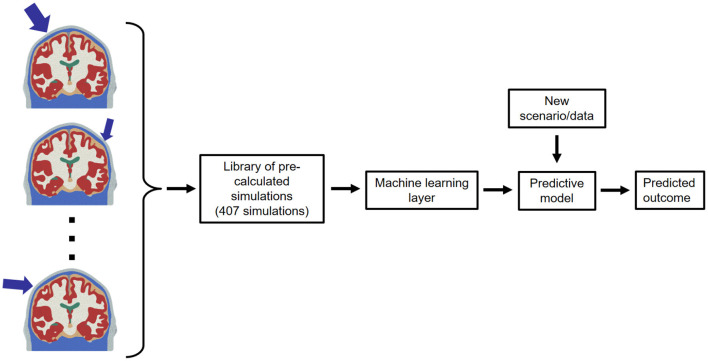
Schematic of the ML layer.